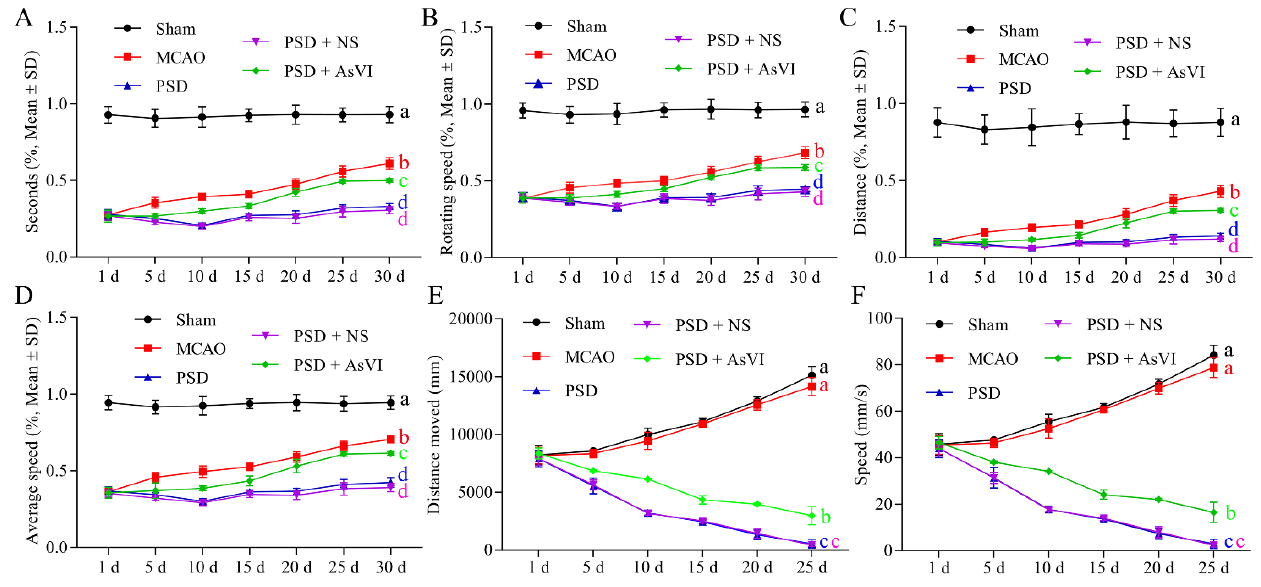
Figure 3. Effects of AsVI on motor functions in locomotor activity and Rotarod test in the open-field experiment in PSD rat model. ( A ) The statistical analysis of the period in the device for each cohort throughout motor detection. ( B ) The statistical analysis of the rotating velocity in each cohort in the course of motor detection. ( C ) The statistical analysis on the distance in each cohort in the course of motor detection. ( D ) The statistical analysis on the average velocity in each cohort in the course of motor detection. ( E ) The statistical analysis on the distance moved in each cohort in the course of the open field test. ( F ) The statistical analysis of the speed in each cohort in the course of the open field test. Data are articulated as means ± SDs. n = 4–6 rats in the cohorts. Distinct letters (a, b, c, d) denote significant differences in various cohorts. p < 0.05.